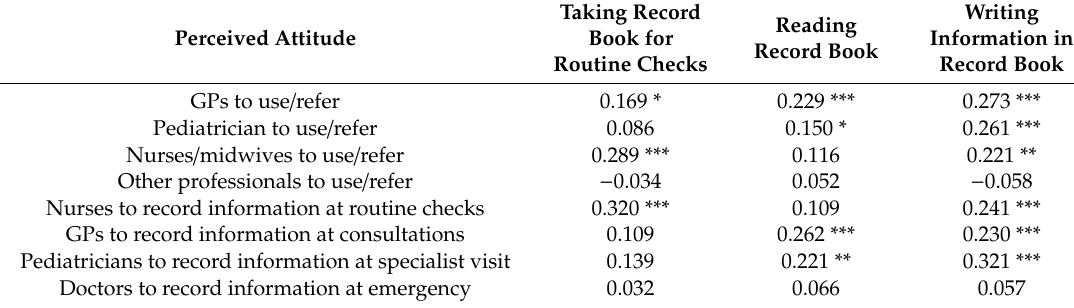
Table 3. Correlation between parent engagement with record book and perceived